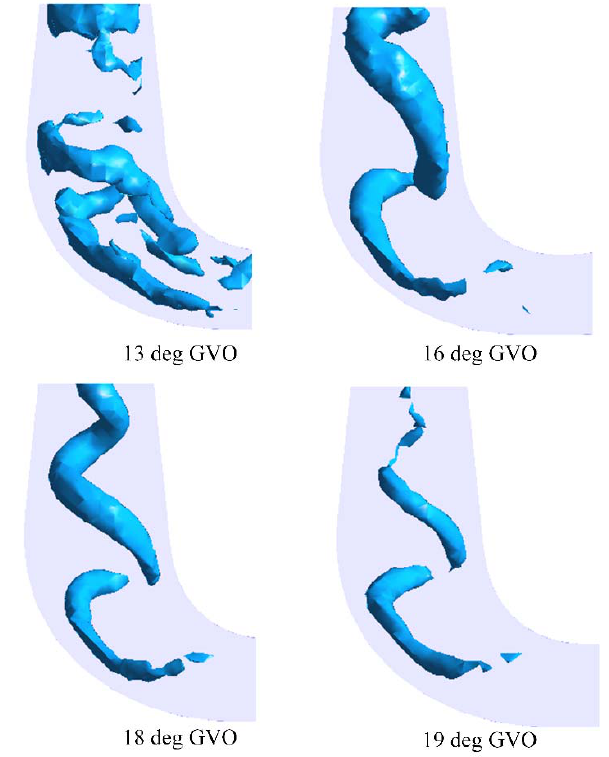
Figure 6. Sketch of vortex rope at the last time step under the four different operating conditions.